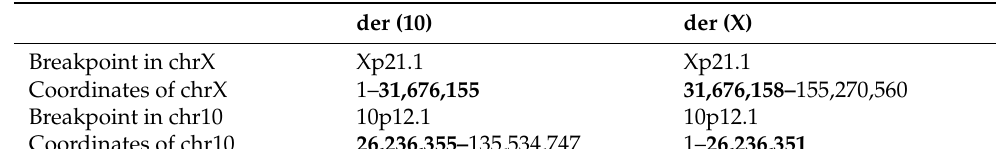
Table 2. Characteristics of the t(X;10)(p21.1;p12.1) balanced reciprocal chromosomal translocation detected in the index patient. Breakpoints are shown in bold.